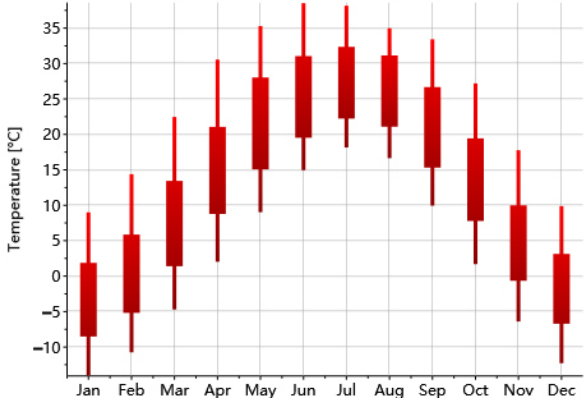
Figure 2. Annual temperatures in Beijing.